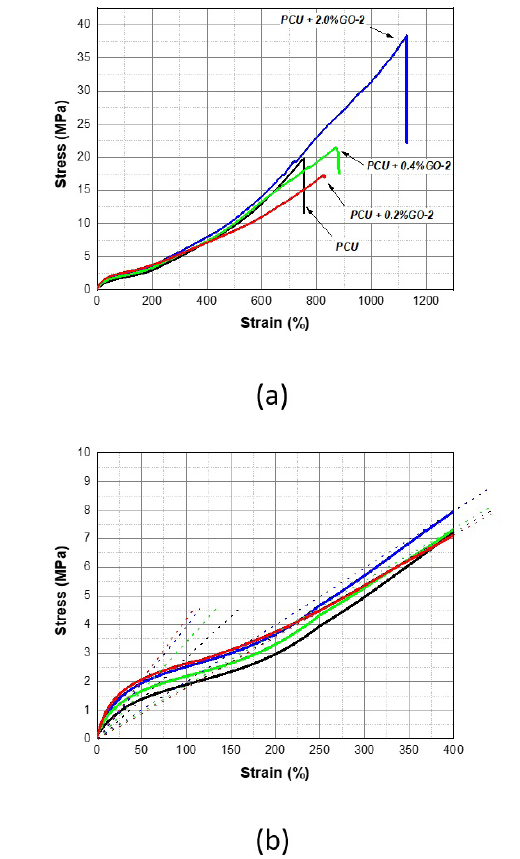
Figure 12. Representatives stress versus strain curves of neat PCU and nanocomposites with GO-2 (a) and expanded area until 400% with dash lines represeting Secant Modulus (b) .